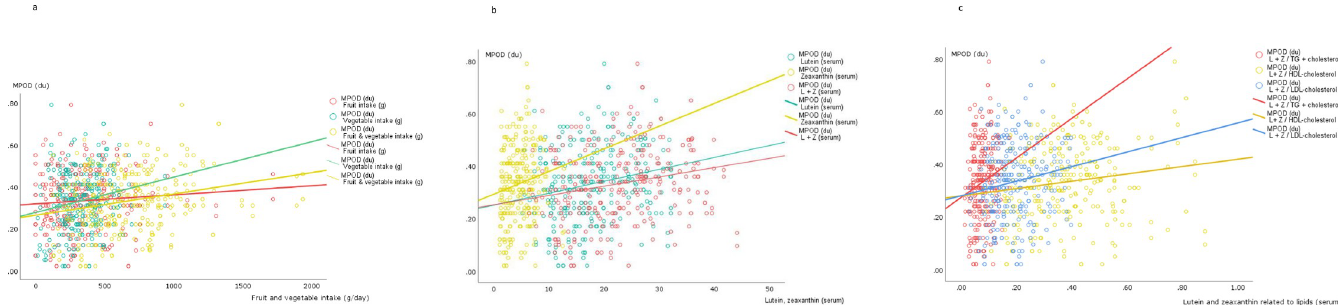
Fig 4. Statistically significant correlations (Spearmn’s rho, ( p value) between MPOD (two eyes/subject, n = 290) and major food sources responsible for their intake. (a), serum lutein and zeaxanthin (b) and serum lutein and zeaxanthin related to lipids (c) (n = 145).